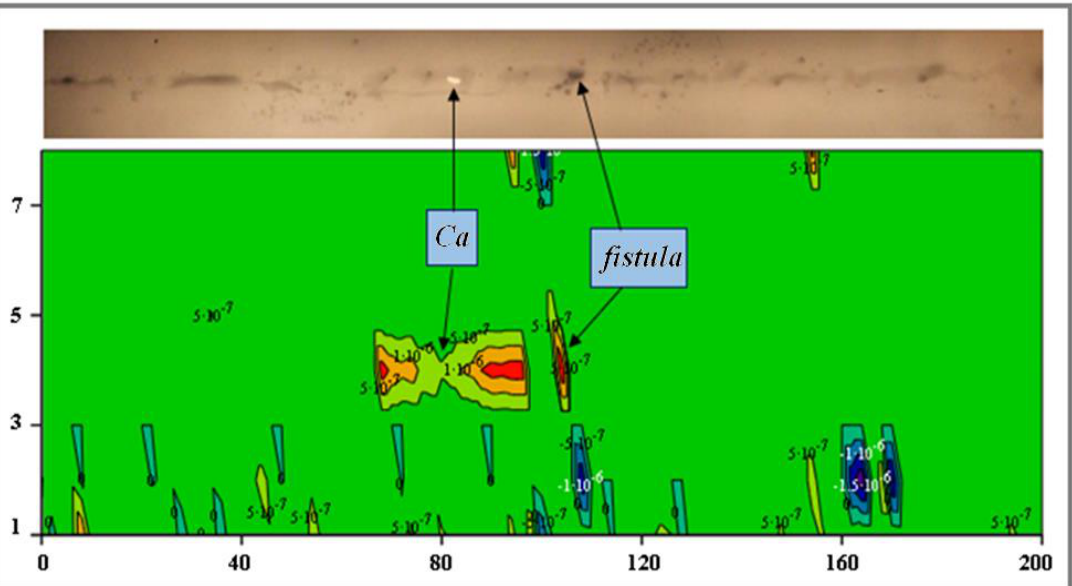
Figure 3. Radiographic image of welding joint in the upper part and potentiogram at SLS =5.699 in the